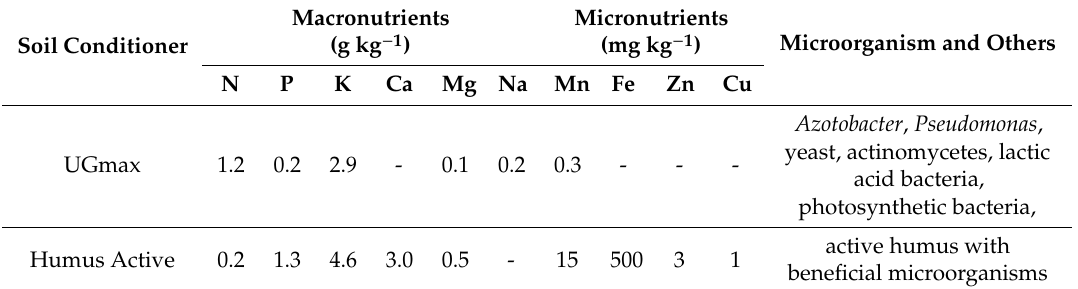
Table 1. Soil conditioner